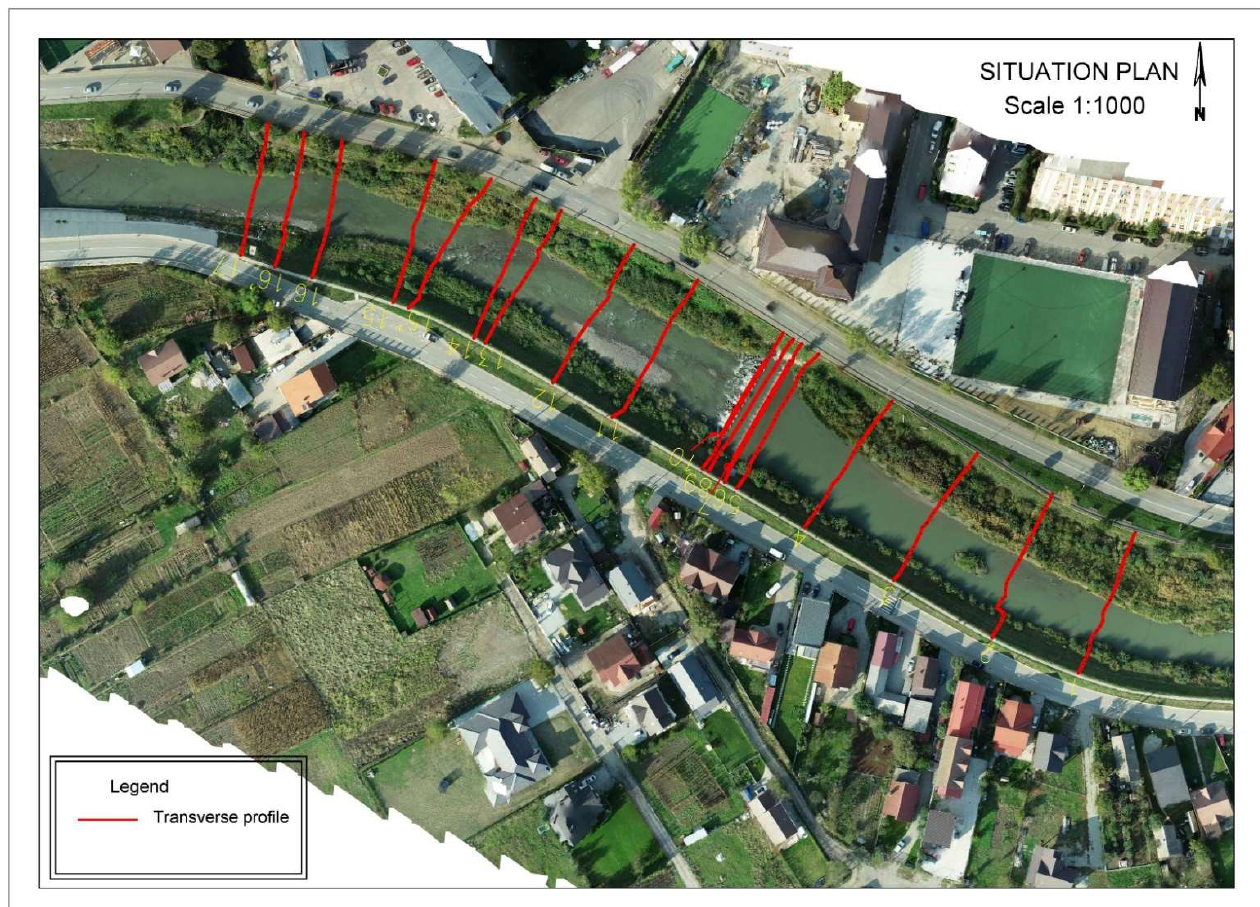
Figure 2. The hydraulic network and the position of the cross sections plotted in the orthophotoplan. The processing of aerial images collected with the DJI Phantom 4 Pro v 2.0 profes-